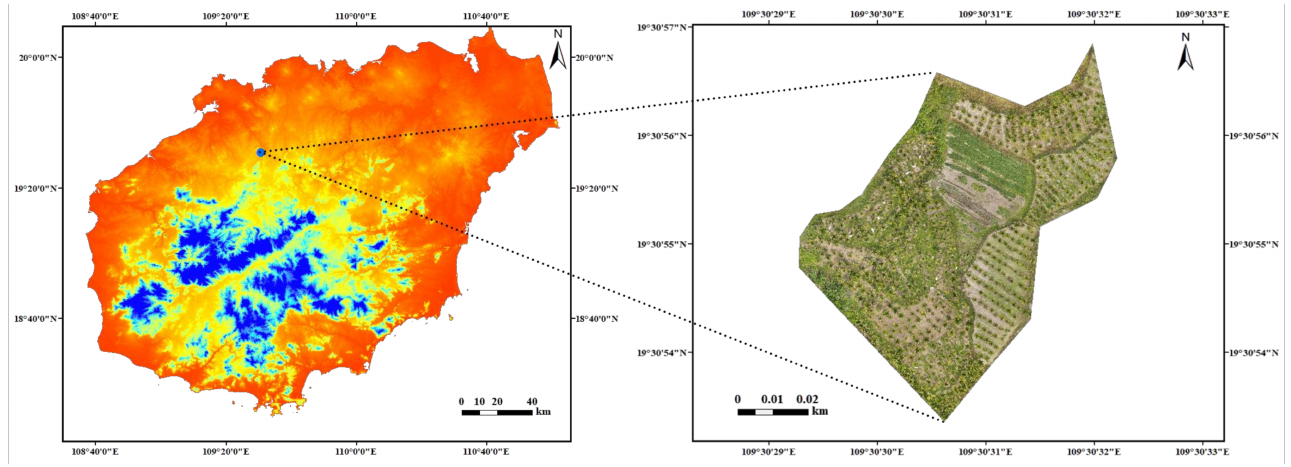
Figure 2. Overview of the research